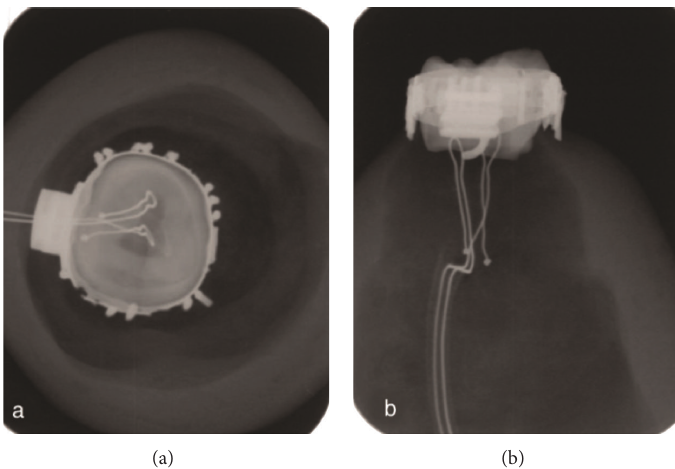
Figure 2: Lateral and occlusal radiograms were taken to ensure that the wire was properly inserted in its place. Two wires in the thermocouple cable can be seen; one of them was placed in the medial fissure of the pulp cap and the other was located in distal fissure.